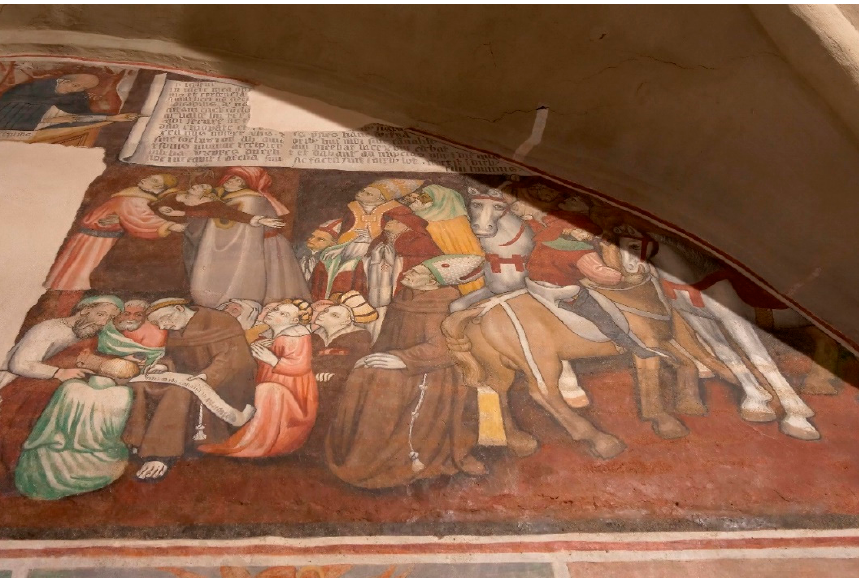
Figure 7. Vincent Ferrer preaching. Santa Maria Assunta Parish Church (Macello, Piedmont). Aymo Duce, circa 1429 (photograph courtesy of Leonardo Guazzo).